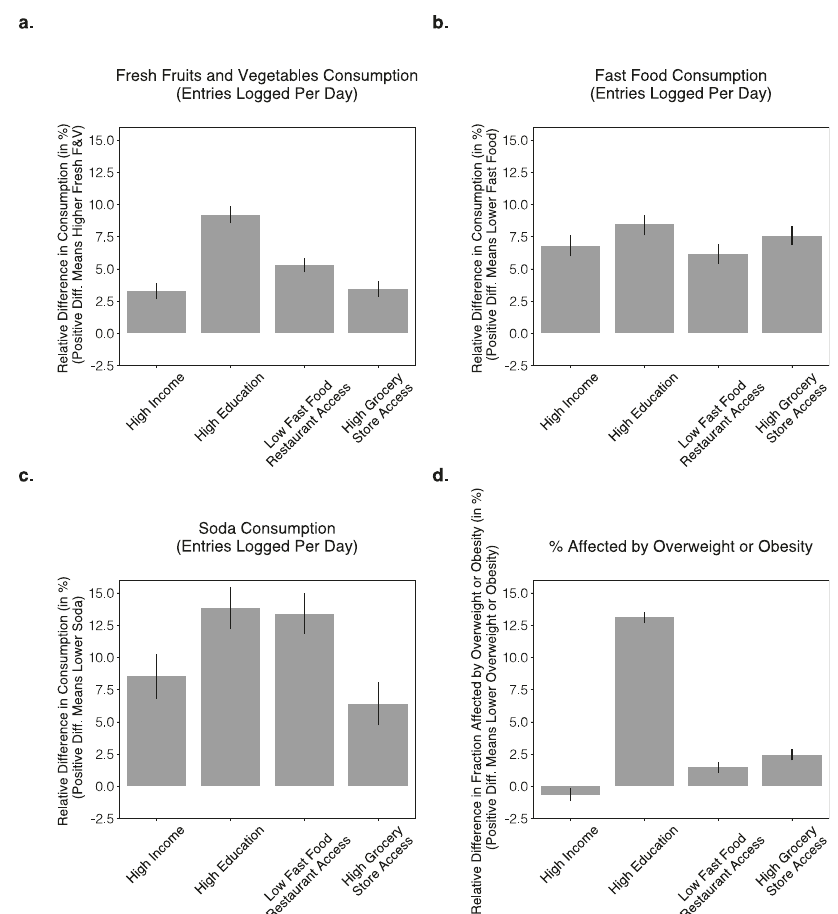
Fig. 4 The association between income, educational attainment, grocery store and fast food access, with food consumption and BMI status. Independent contributions of high income (median family income higher than or equal to $70,241), high educational attainment (fraction of population with college education 29.8% or higher), high grocery store access (fraction of population that is closer than 0.5 miles from nearest grocery store is greater than or equal to than 20.3%), and low fast food access (less than or equal to 5.0% of all businesses are fast-food chains) on relative difference in consumption of a fresh fruits and vegetables, b fast food, c soda, and d relative difference in fraction affected by overweight or obesity (BMI > 25). Cut points correspond to median values. Y -axes are oriented such that consistently higher is better. Estimates are based on matching experiments controlling for all but one treatment variable, across N = 4911 matched pairs of zip codes (Methods). Bar height corresponds to mean values; error bars correspond to 95% bootstrap con fi dence intervals (Methods). While the most highly predictive factors vary across outcomes, only high educational attainment was associated with a sizeable difference of 13.1% in the fraction affected by overweight or